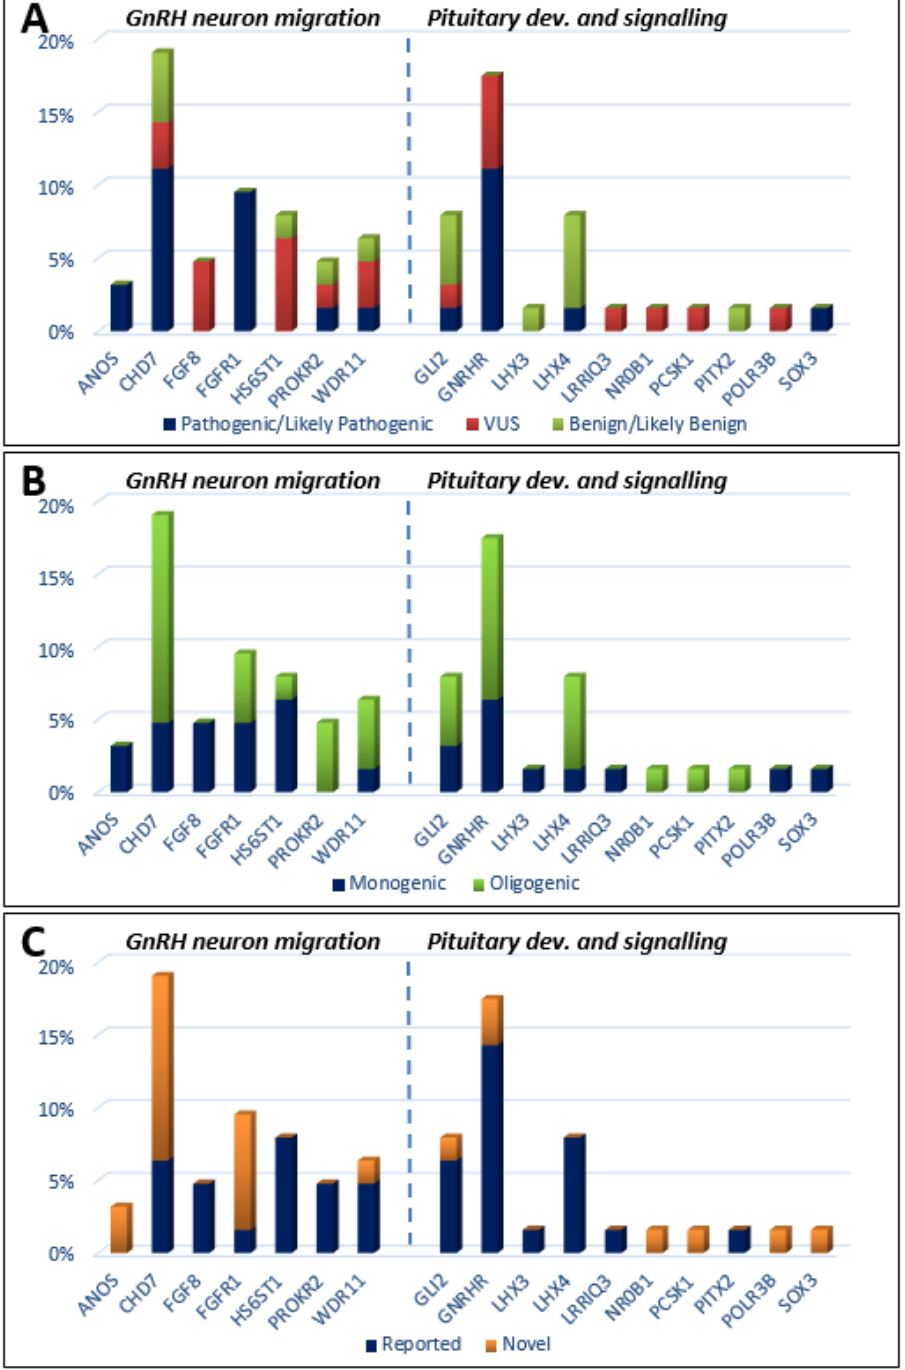
Figure 1. Histograms showing the prevalence of mutations among KS patients, which are classified by three metrics: ( A ) mutation severity (ACMG criteria: pathogenic/likely pathogenic, VUS variant of unknown significance, benign/likely benign); ( B ) oligogenicity; ( C )